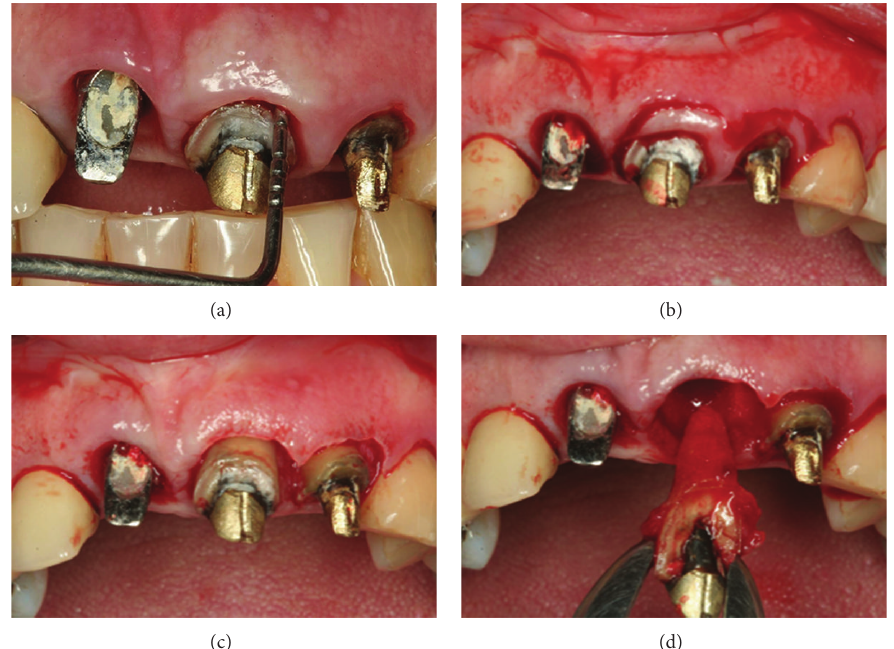
Figure 5: (a, b, c) Clinical crown lengthening of the anterior teeth to correct the uneven gingival level. (d) Atraumatic extraction of the left central incisor.